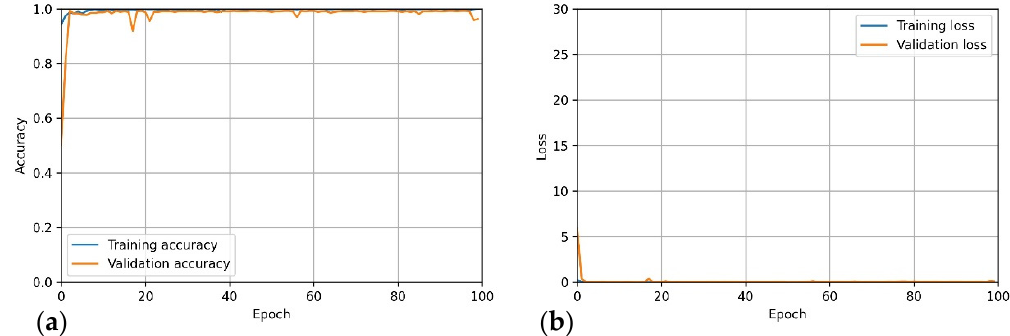
Figure 6. Results of CNN training for the Lorenz system, ( a ) accuracy, ( b ) and loss curves over 100 epochs.